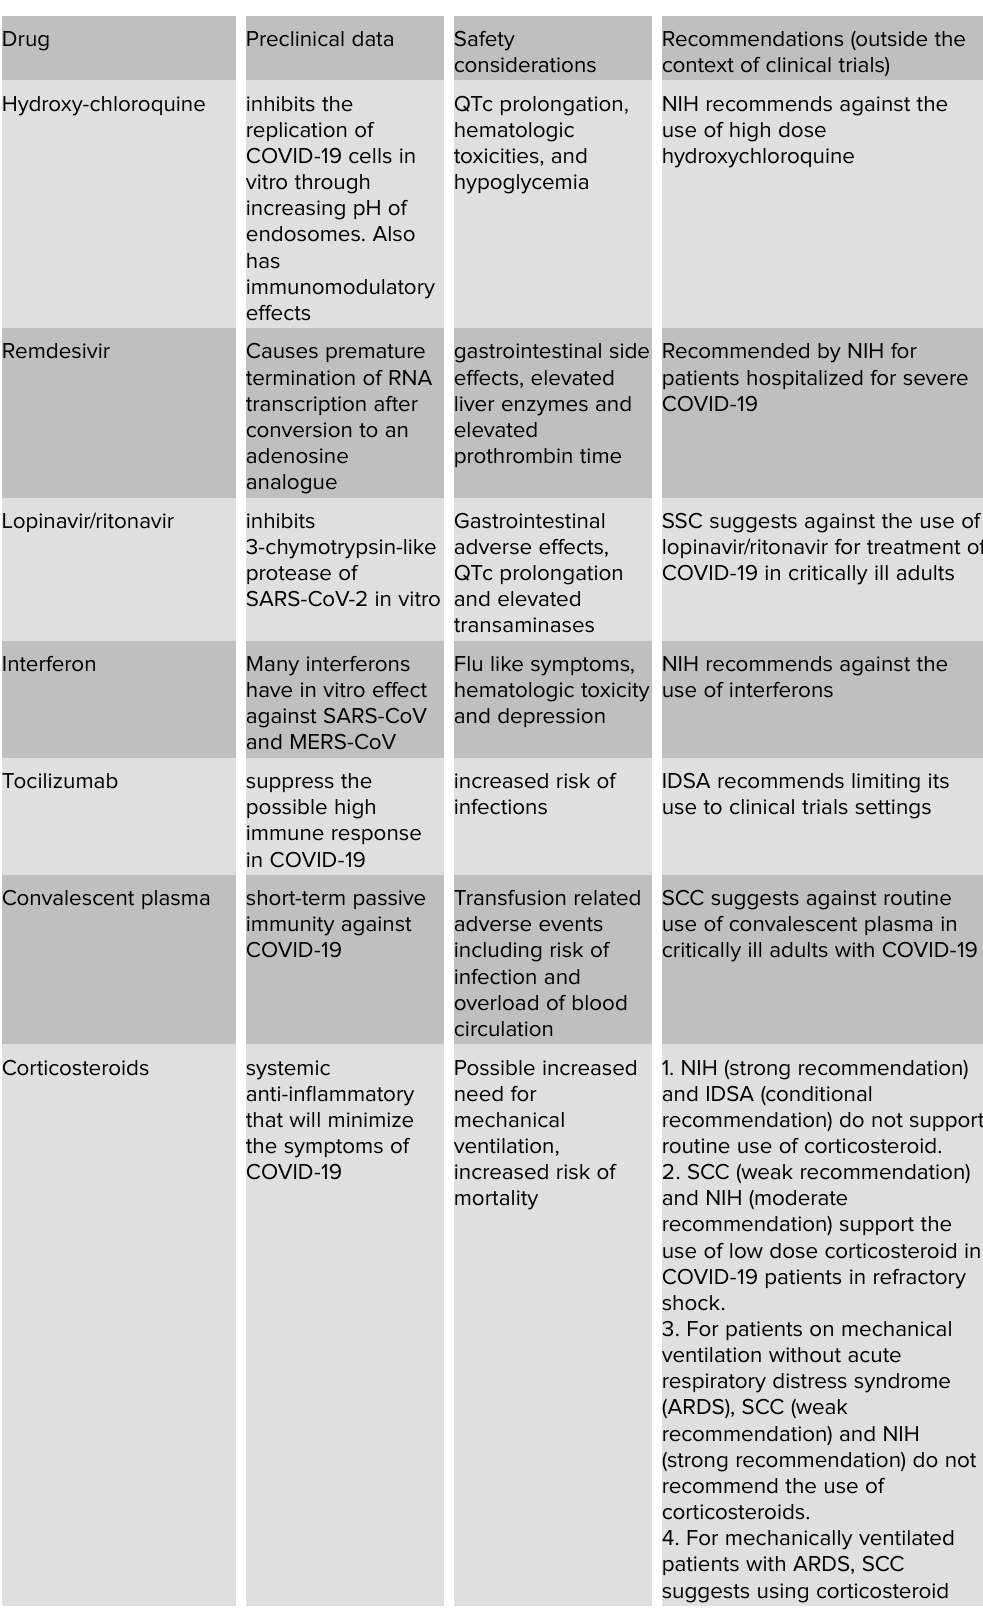
TABLE 1: Summary of current data on selected COVID-19